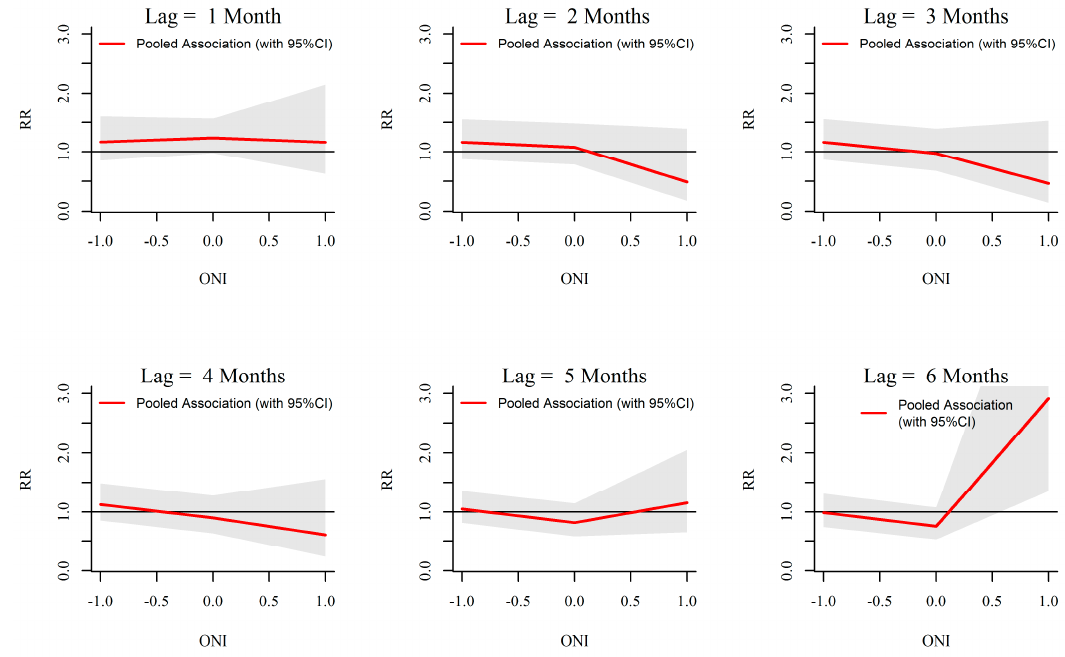
Figure 11. Relative risk (RR) of monthly dengue cases by ONI at specific lags in 10 MOH divisions in Kalutara district, Sri Lanka, 2009–2013. The figure illustrates the predicted curves from meta-regression for different lag periods; 1, 2, 3, 4, 5 and 6 months. The shaded areas represent 95% confidence intervals.